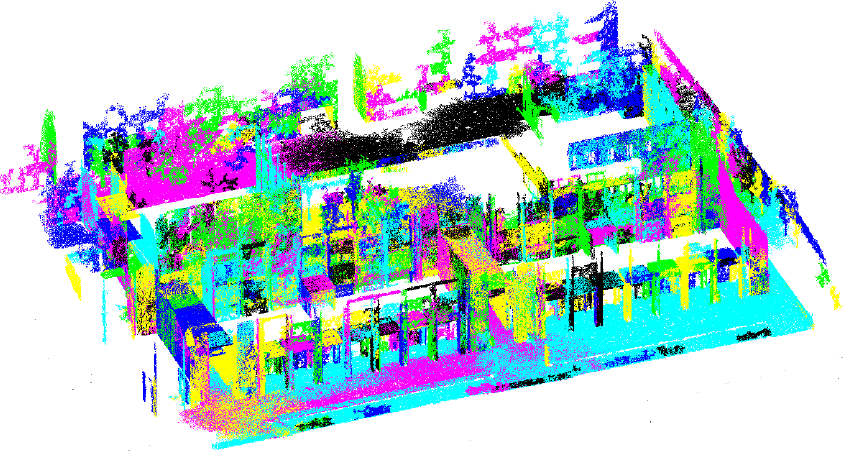
Figure 4. Segmentation of a point cloud into planar regions. Colors represent individual planar regions detected by the algorithm.